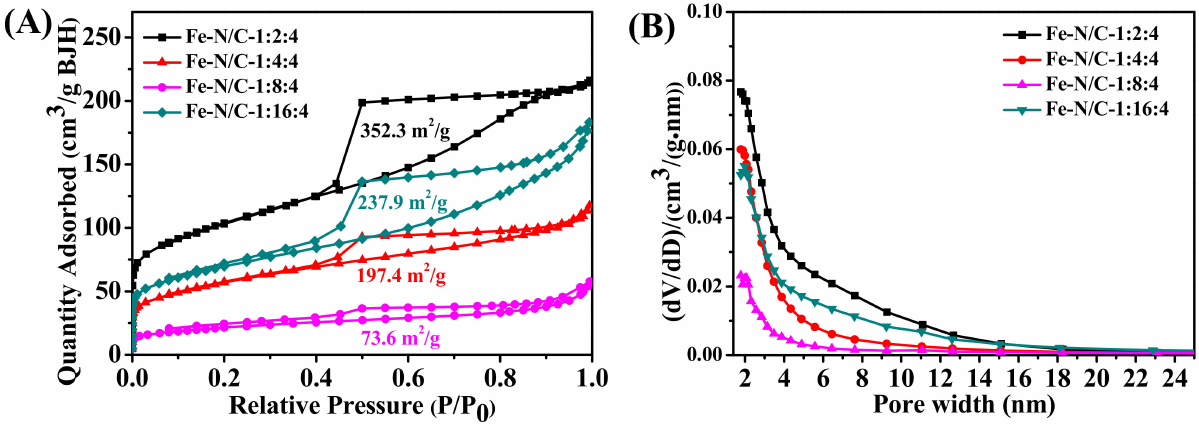
Figure 7. The N 2 adsorption–desorption isotherms ( A ) and the corresponding pore size distributions ( B ) of Fe-N/C-1:2:4, Fe-N/C-1:4:4, Fe-N/C-1:8:4, and